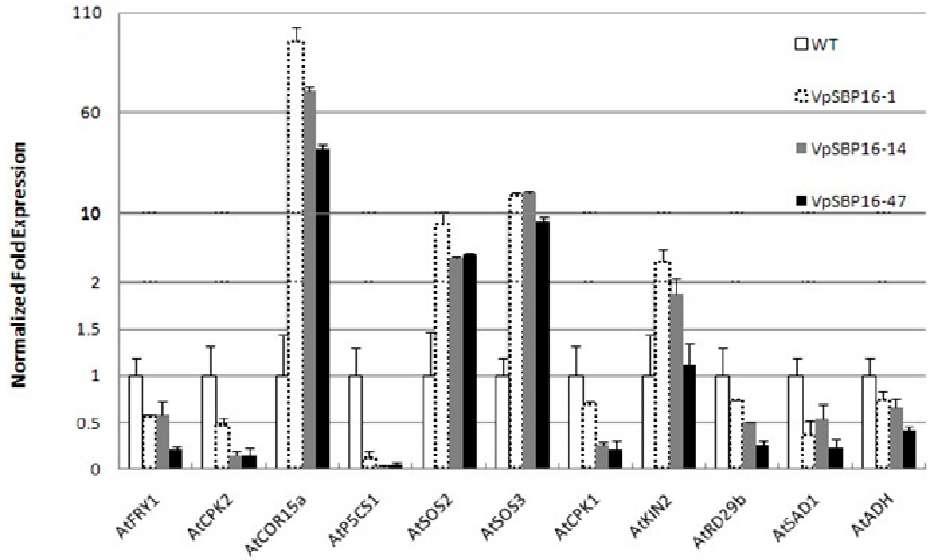
Figure 8. Expression levels of abiotic stress responsive genes in 3-week-old WT and VpSBP16 transgenic A. thaliana plants. AtActin1 was used as internal control for qRT-PCR. Mean values and SDs were obtained from three technical and three biological.